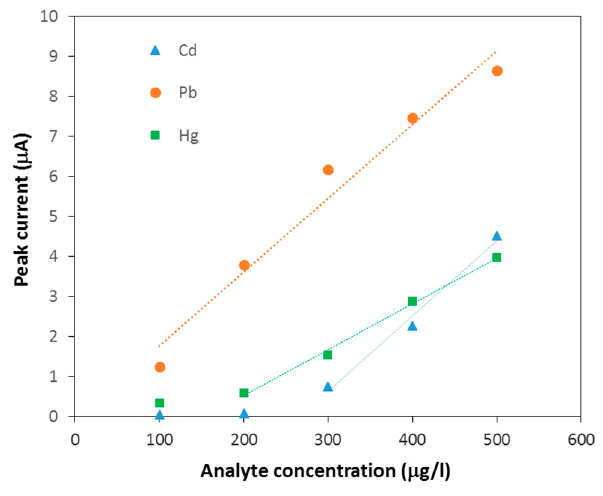
Figure 6. Peak DPASV current for analysis of Pb, Cd and Hg using Graphene/PDMS with 0.5 mg/mL CNTs with different analyte